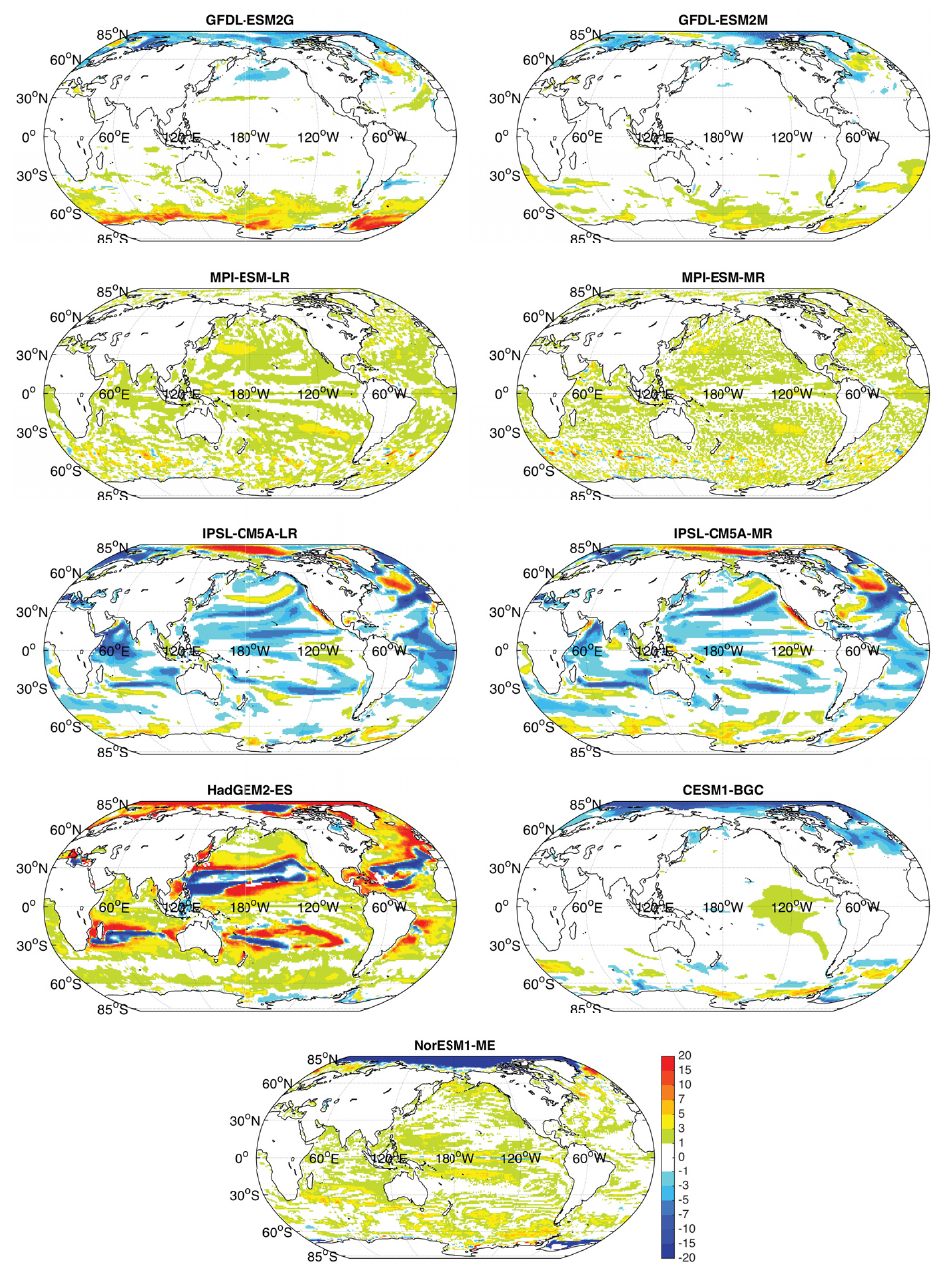
Figure 11. The percent change in the pe-ratio between the 2090s and the 1990s).